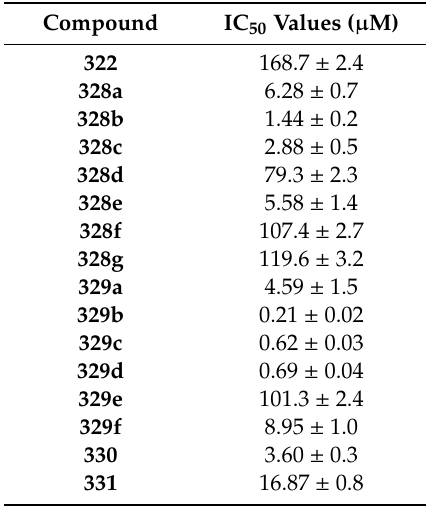
Table 39. Inhibitory e ff ect (IC 50 values in µ M) of compounds 322 and 328a – 331 against β -secretase (BACE1)